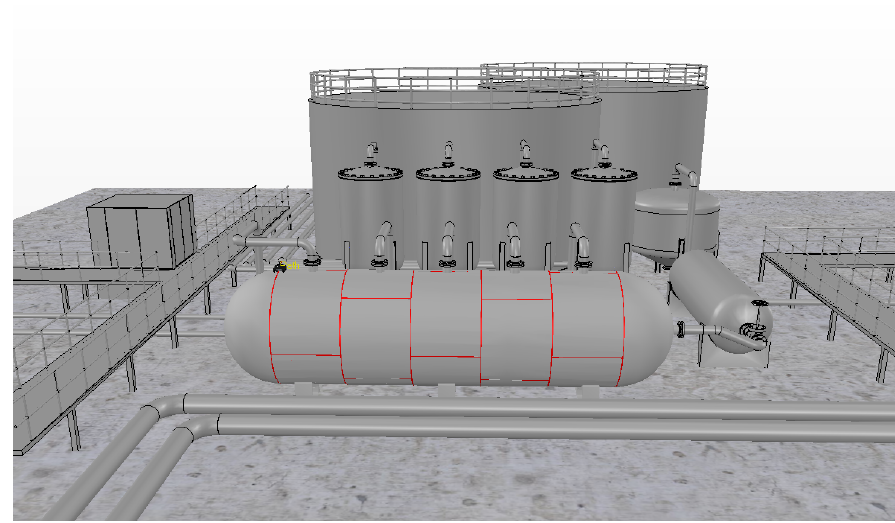
Figure 17. Scene used of a refinery with storage ranks and weld beads in the V-REP